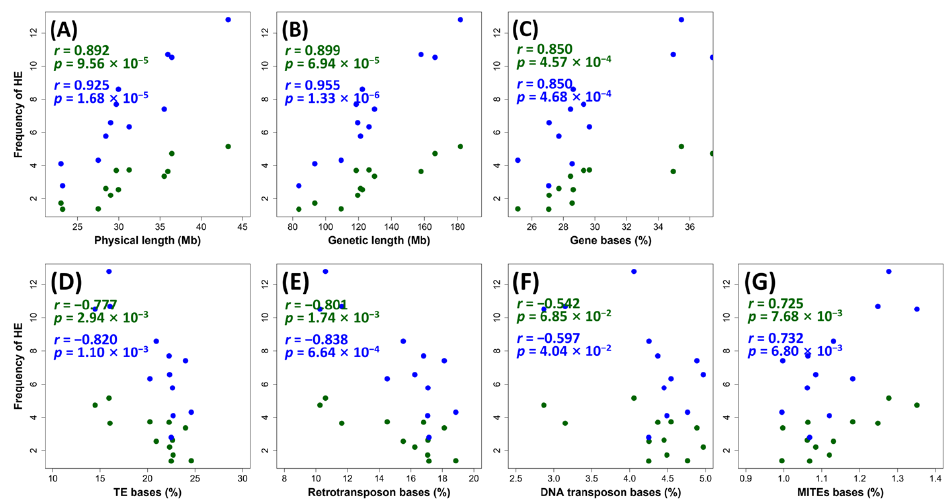
Figure 2. Correlation between HE frequency and different chromosome features. ( A ) physical length, ( B ) genetic length, ( C ) percentage of gene bases, ( D ) percentage of TE bases, ( E ) percentage of retrotransposon bases, ( F ) percentage of DNA transposon bases, ( G ) percentage of MITEs bases. Each dot represents a chromosome. The x -axis shows the genomic features of chromosomes. The y -axis shows the HE frequency of chromosomes. Chromosomes, correlation coefficients, and p -values of S2 and S4 plants are shown in green and blue colors, respectively.